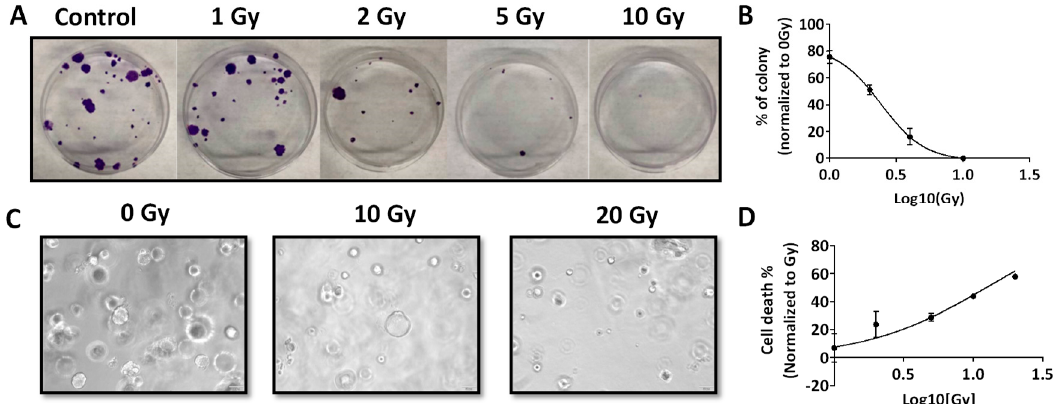
Figure 2. Radiation response of RP-MOC1 in 2D culture and 3D organoids. ( A ) Digital photographs of crystal violet stained RP-MOC1 cells on day 15 post radiation compared control. Radiation dose response curves of RP-MOC1 cells in 2D ( B ) RP-MOC1 organoids ( C ). Bright field microscopy images ( D ) of RP-MOC1 organoids showing a reduction in size post radiation. Data are expressed as mean ± SEM. Image was acquired at 20× magnification.